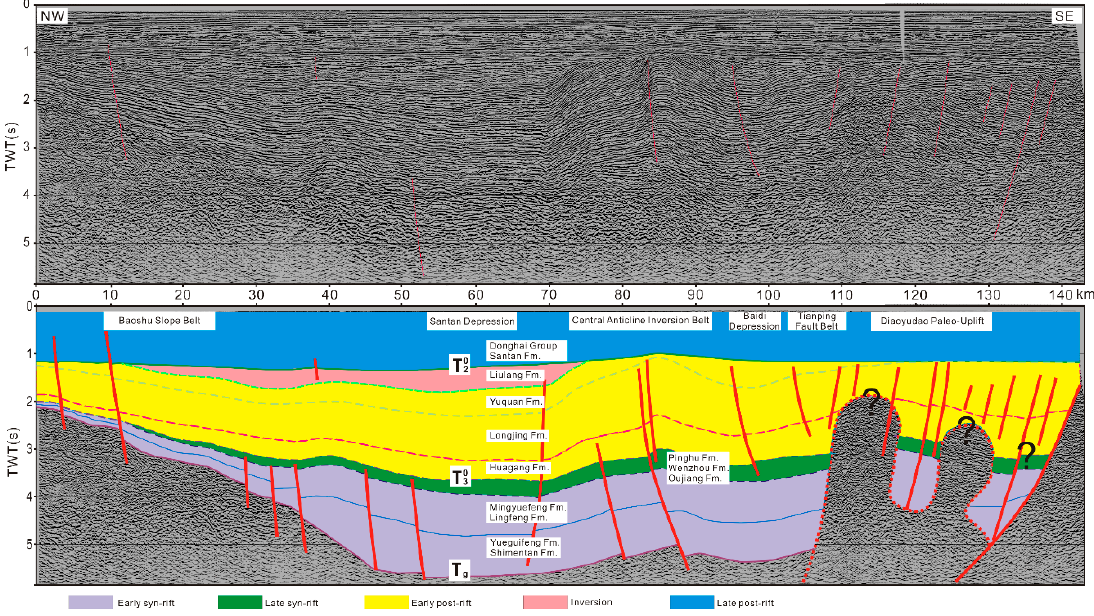
Figure 7. Xihu Sub-basin tectonic cross-section (seismic line location is indicated in Figure 6). The seismic horizons can be referred to Figure 3. Question marks indicate uncertainties in the interpretation.